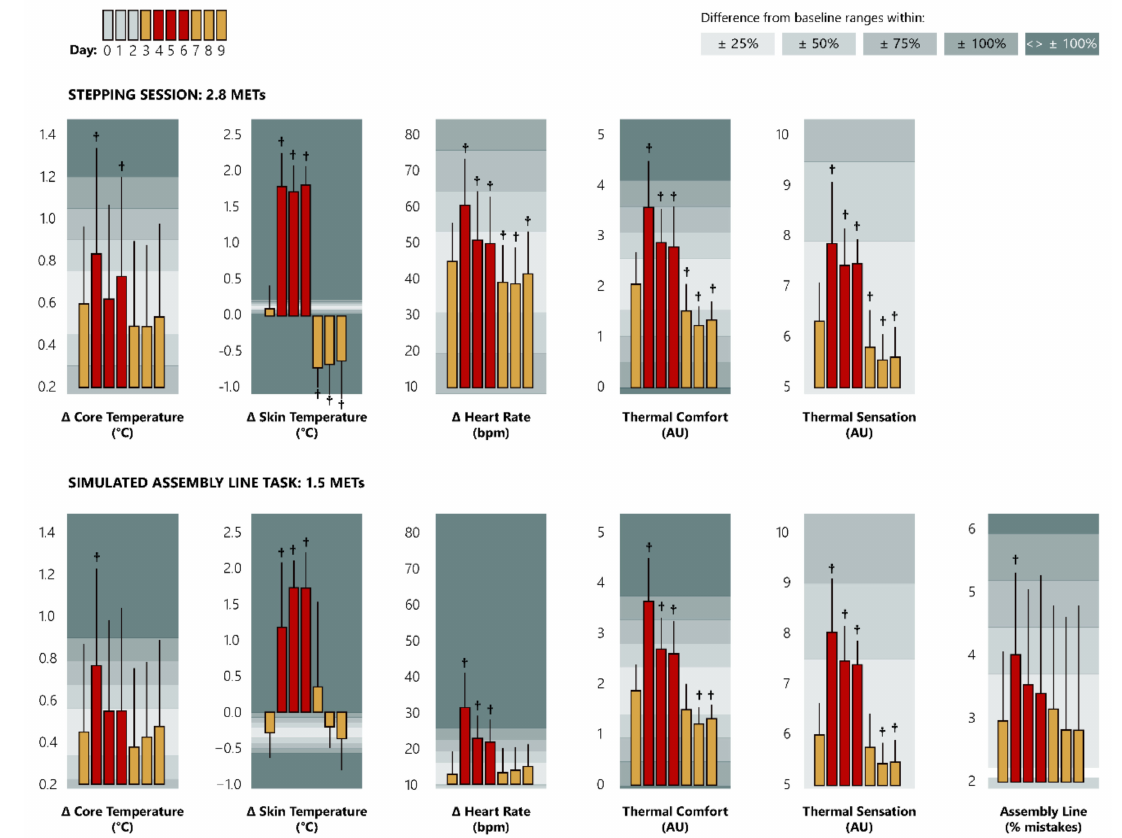
Figure 3. Differences (means ± sd) in thermal strain and labour efficiency during stepping (top graph) and simulated assembly line task (bottom graph) between neutral and hot days. Data are presented as delta ( ∆ ) differences from the pre-heat-wave sleep (sleep time of days 0–2), depicting the increase/decrease in the physiological strain experienced by our participants. Yellow and red bars correspond to the days pre-/post and during the heat-wave, respectively. The first yellow bar (day: 3) represents the average of each variable across the pre-heat-wave period (days 1–3). Grey areas in the background represent the magnitude (%) of difference compared to the pre-heat-wave variables. AU indicates arbitrary units. Cross signs indicate statistically significant differences compared to the pre-heat-wave period, at p <